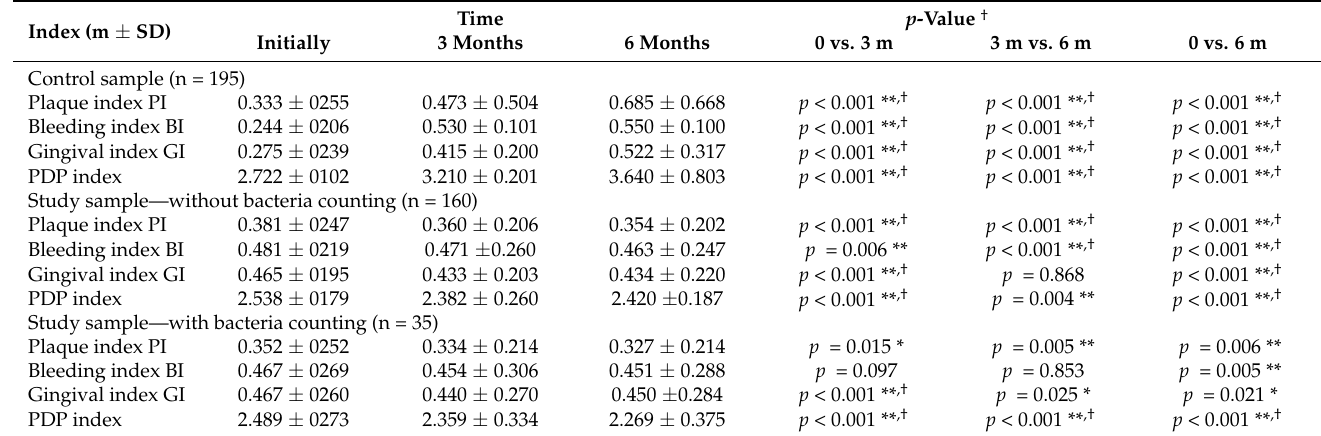
Table 4. The comparative evolution of periodontal indexes in the investigated samples.